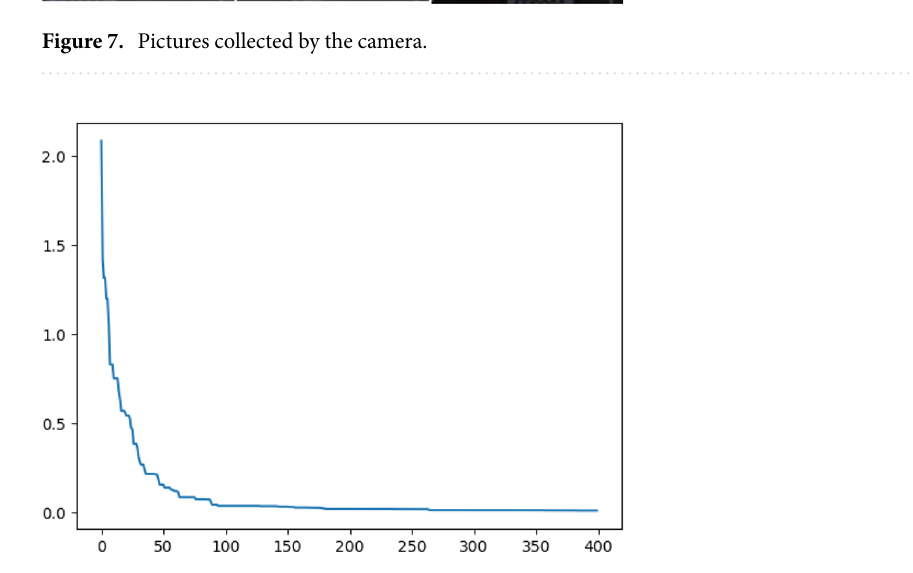
Figure 8. The objective function curve obtained by the improved grey wolf algorithm.